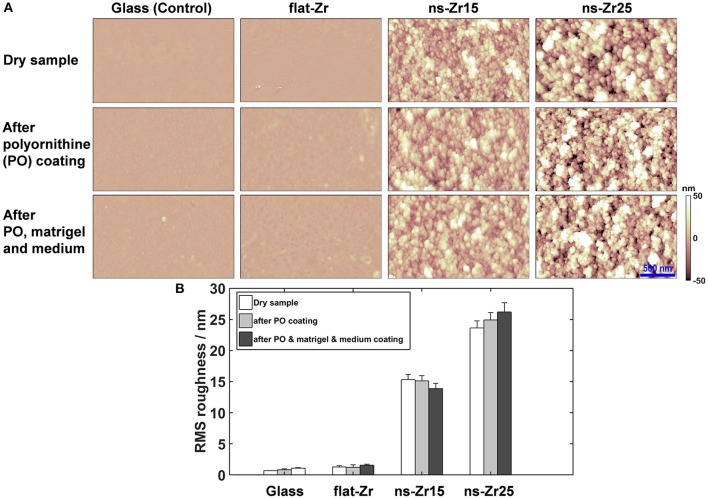
Surface characterization of the different substrates after polyornithine coating and incubation with diluted matrigel and culture medium. (A) The images display representative top views of AFM surface characterisations of the diverse indicated substrate conditions glass-control (Control), flat zirconia produced by e-beam evaporation (flat-Zr), nanostructured zirconia produced by SCBD with the roughnesses 15 nm rms (ns-Zr15), respectively 25 nm rms (ns-Zr25) in the dry, original condition (first row), after polyornithine coating (middle row) and matrigel/medium incubation (last row). (B) The graph summarizes the quantification of the roughness before and after these different treatments obtained from the AFM images.